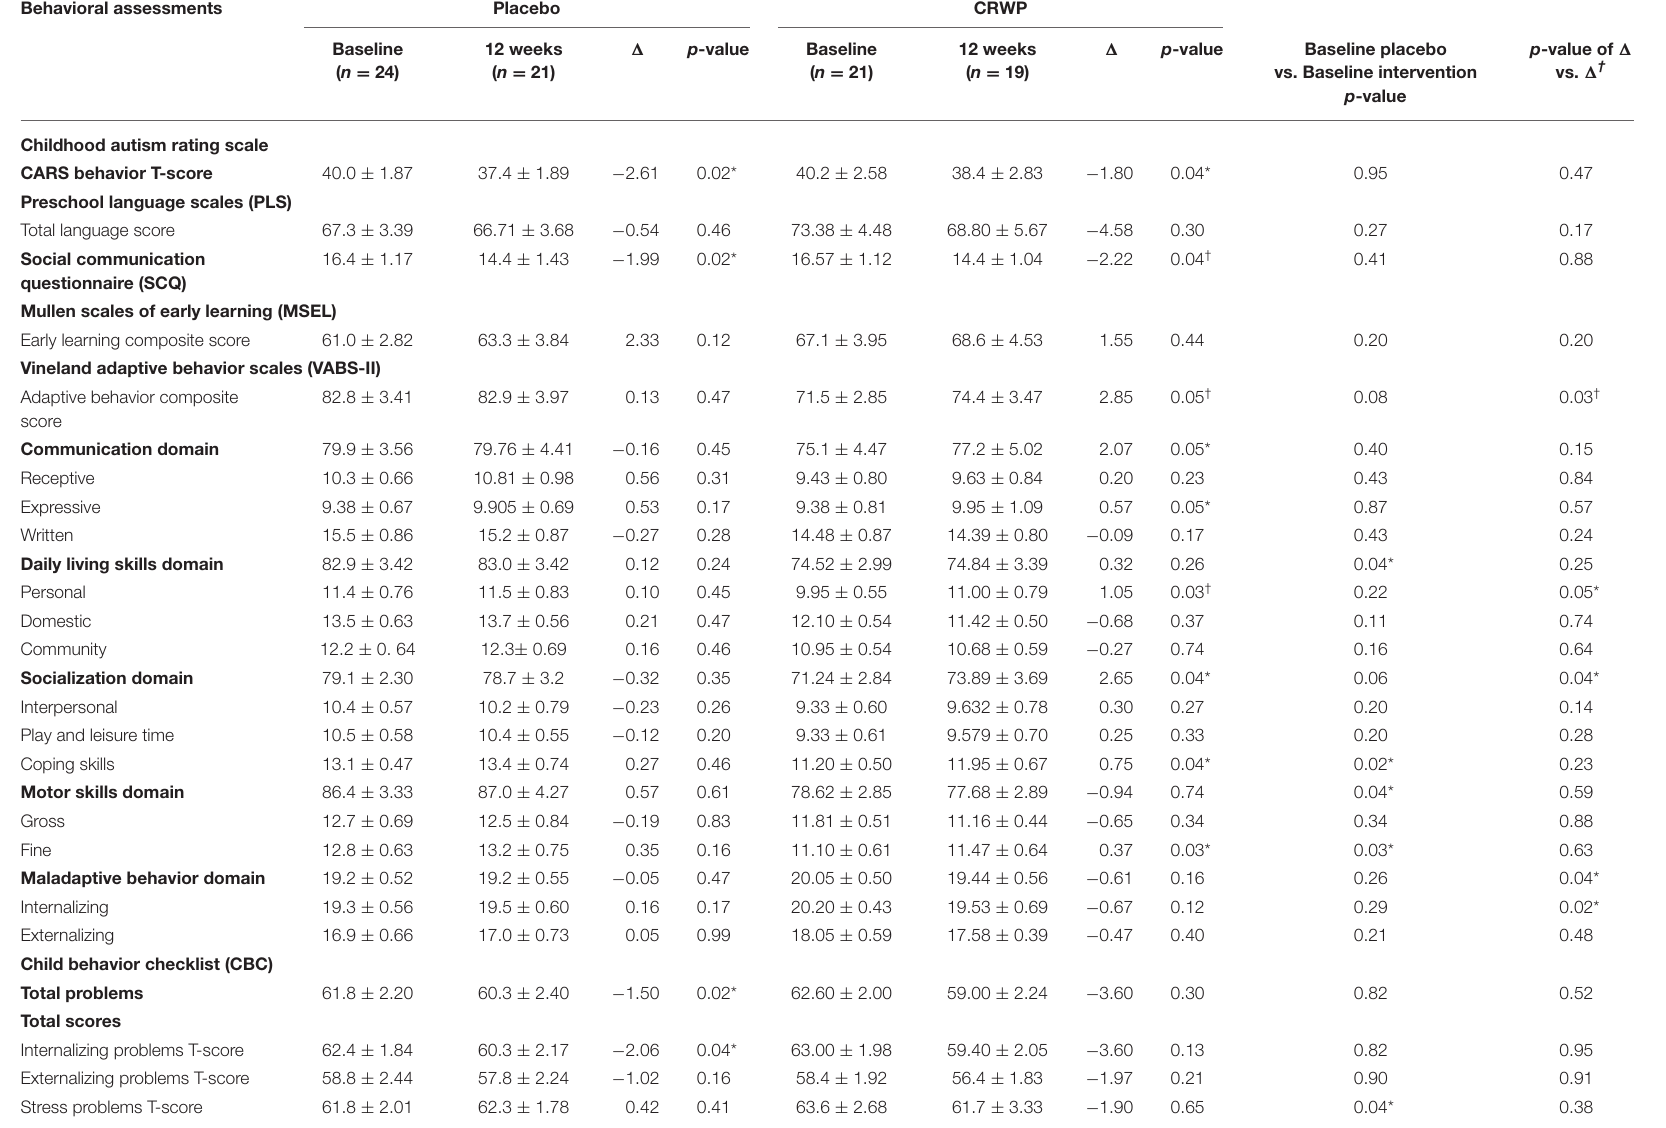
TABLE 2 | Changes in behavioral assessments in placebo and CRWP group from baseline to follow-up. Behavioral